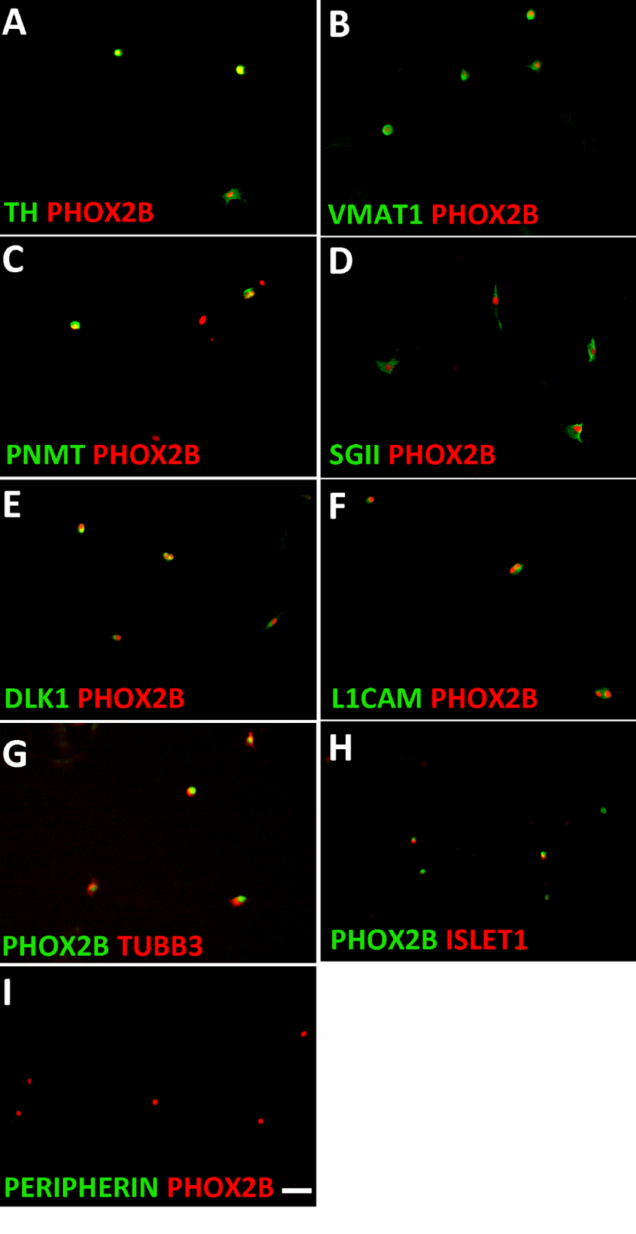
Figure 2. Characterization of mouse adrenal chromaffin cells. Dissociated adrenal cells were plated on porn/laminin-coated dishes in serum-free culture medium and analyzed after cell attachment. Double-immunostaining showed that all PHOX2B-positive cells co-express the noradrenergic proteins TH ( A ) and VMAT1 ( B ). The chromaffin cell-specific proteins PNMT ( C ), SGII ( D ), and DLK1 ( E ) are expressed in 57 ± 3%, 92 ± 2% and 91 ± 4% of PHOX2B-positive cells, respectively. The neuron- specific proteins L1CAM ( F ) and TUBB3 ( G ) are expressed by virtually all chromaffin cells, whereas ISLET1 is only detected in a subpopulation ( H ), and PERIPHERIN is virtually absent in chromaffin cells ( I ). Magnification bar, 60 µ